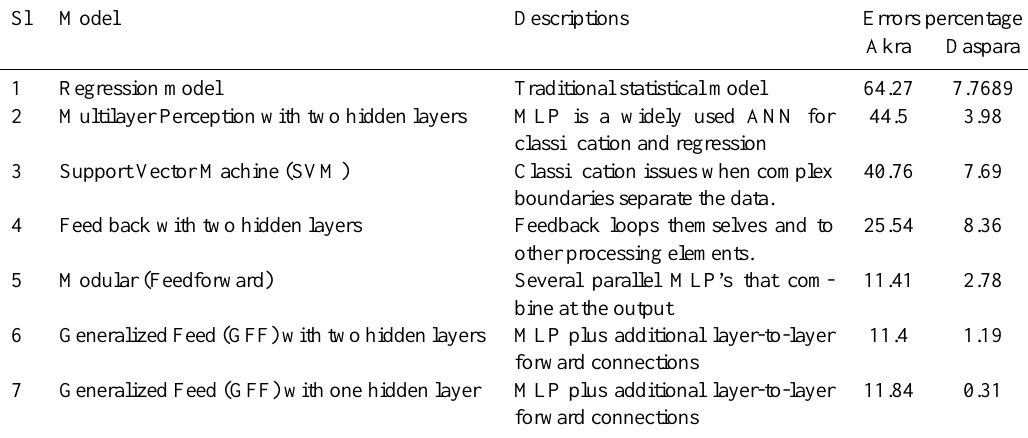
Table 4. Performance of ANN at various